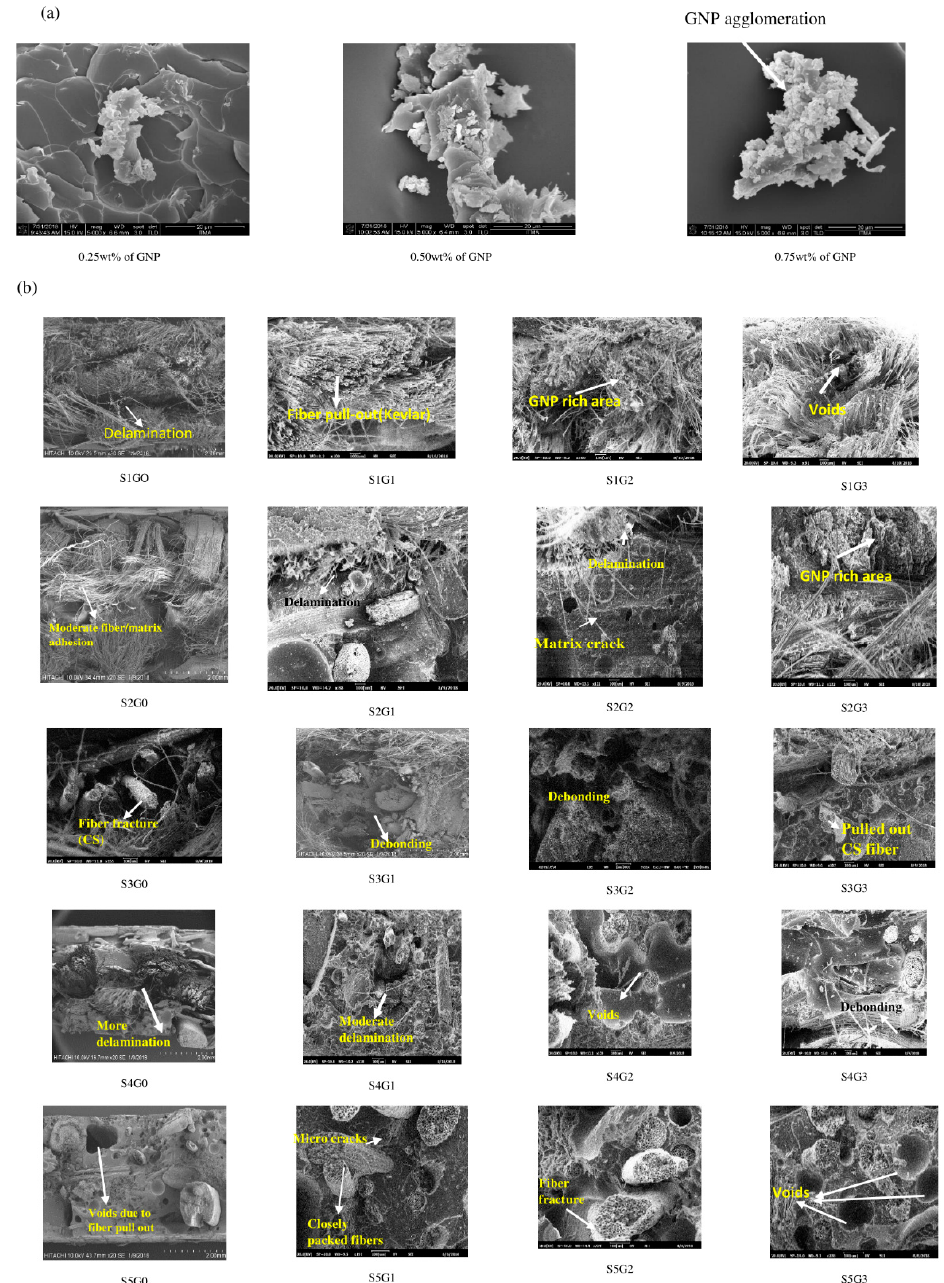
Figure 13. ( a ) The FE-SEM images of the tensile-fractured specimens at different GNP wt.% and ( b ) the SEM images of tensile-fractured